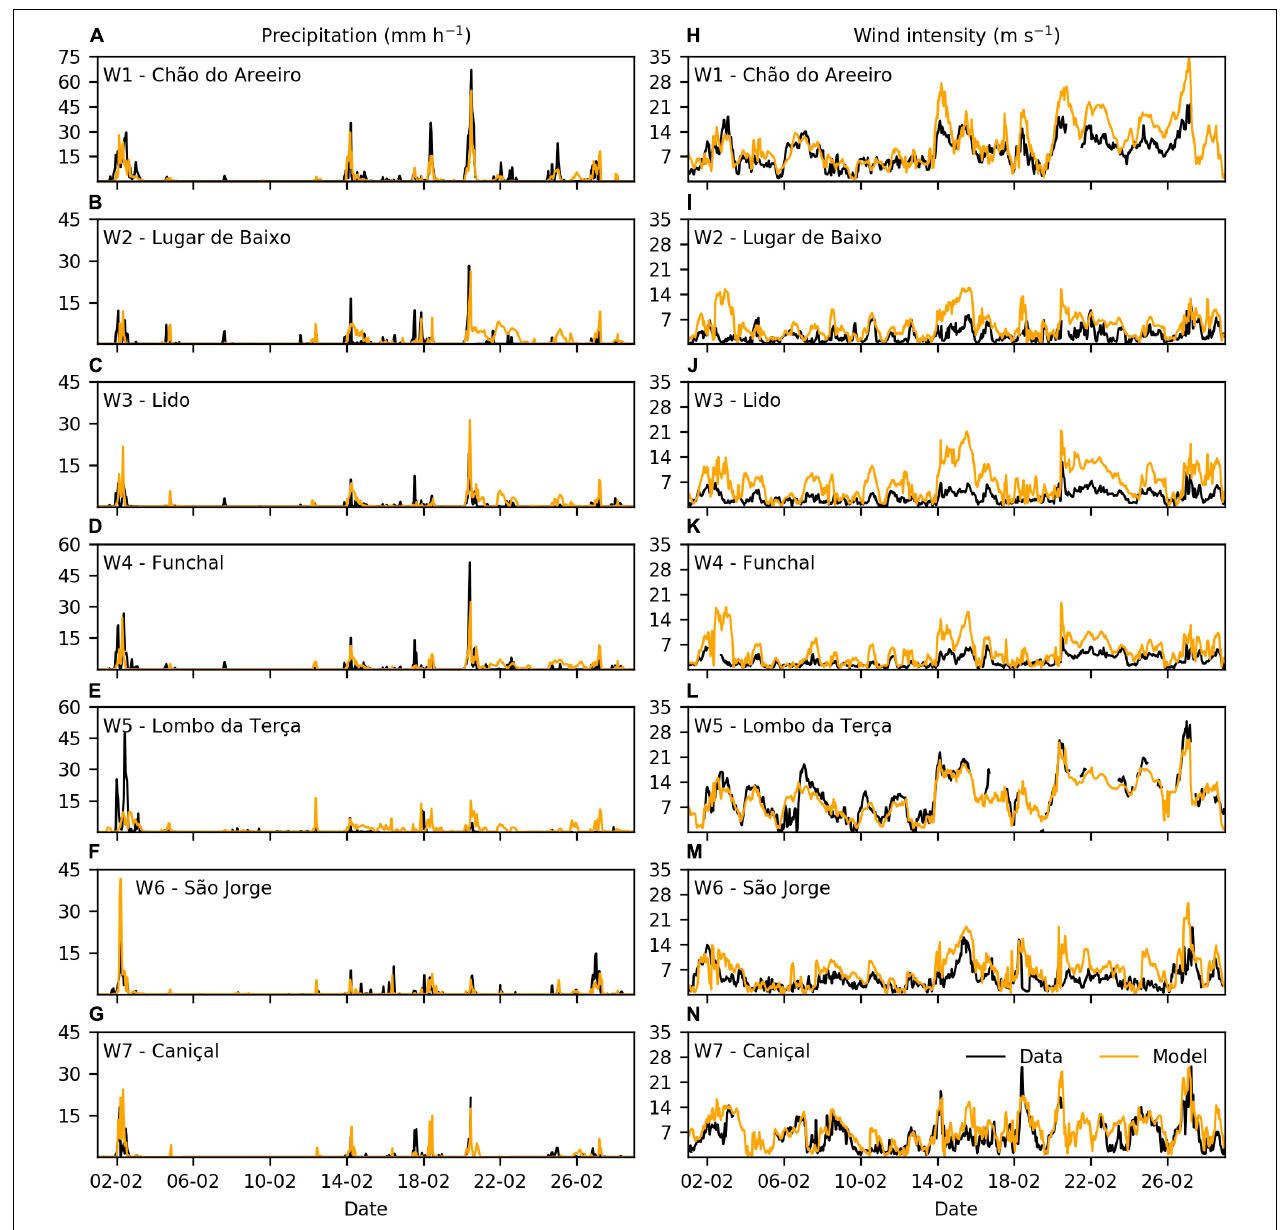
FIGURE 5 | Comparison between the data recorded by the meteorological stations (black line) and the COAWST model results (orange line) for (A–G) precipitation (mm h − 1 ; left panel) and (H–N) wind intensity (m s − 1 ; right panel) during February 2010. Note the changes on the precipitation